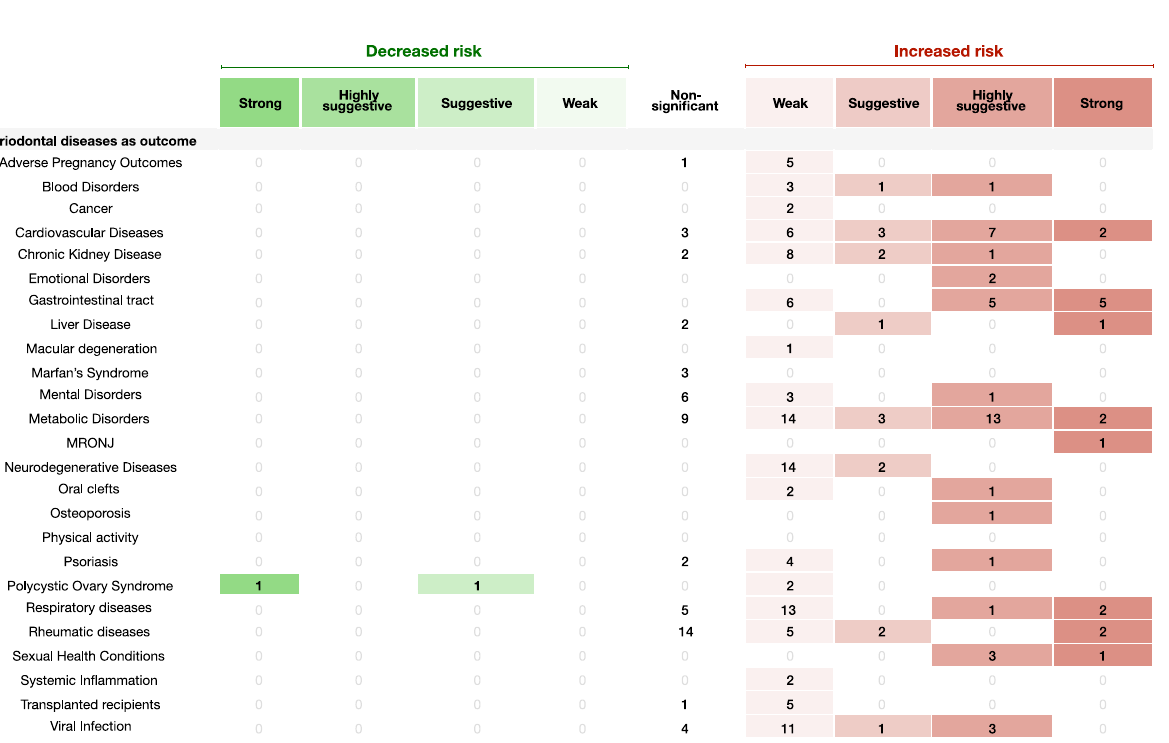
Fig. 4 | Evidence grading diagram on periodontal diseases as an outcome of a respective NCD. The right side displays associations that increase the risk for the respective systemic NCD (in red), whereas the left side shows associations that